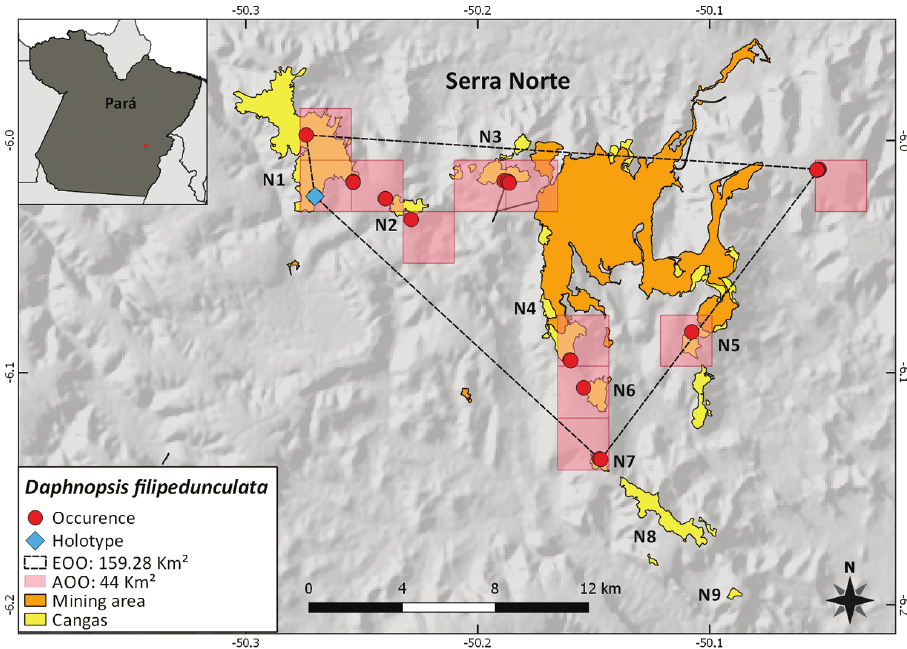
Figure 4. Distribution of Daphnopsis filipedunculata Nevling & Barringer along the Serra dos Carajás with convex polygon and grids of 4 km 2